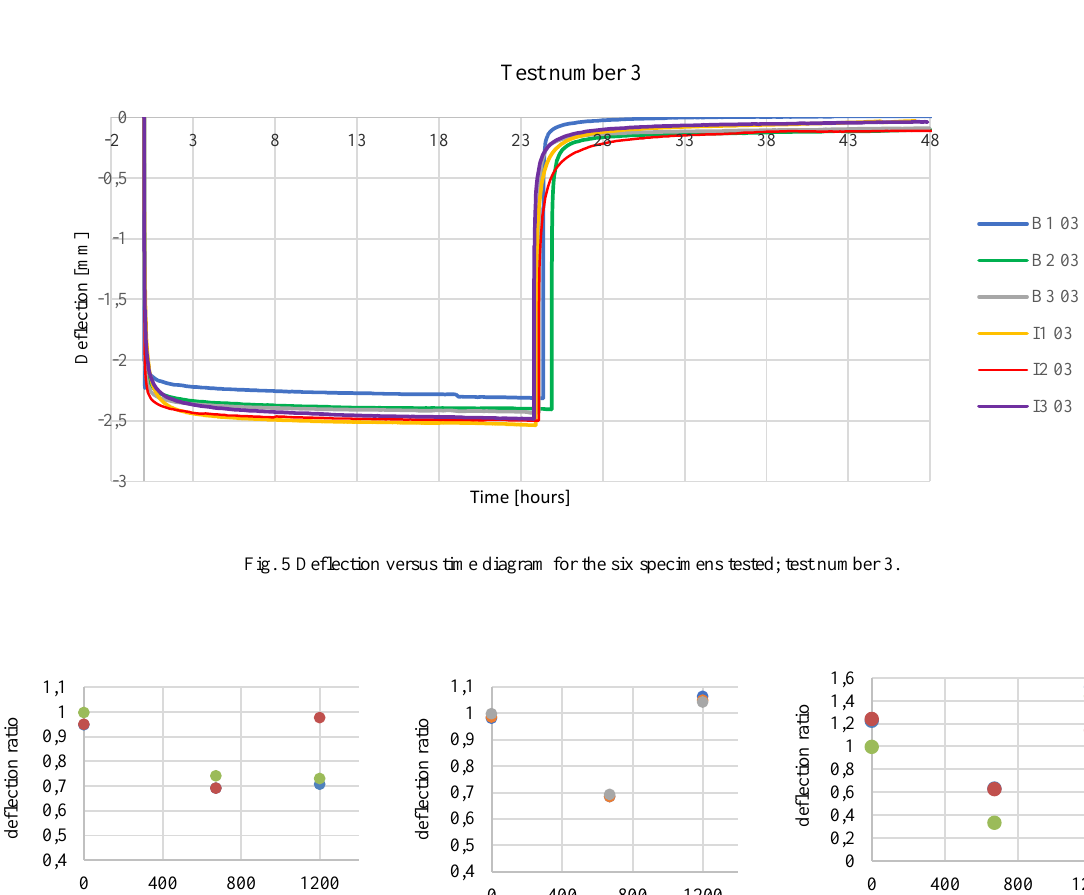
Fig. 4 Specimen B 02 during the recovery phase of test number 3.